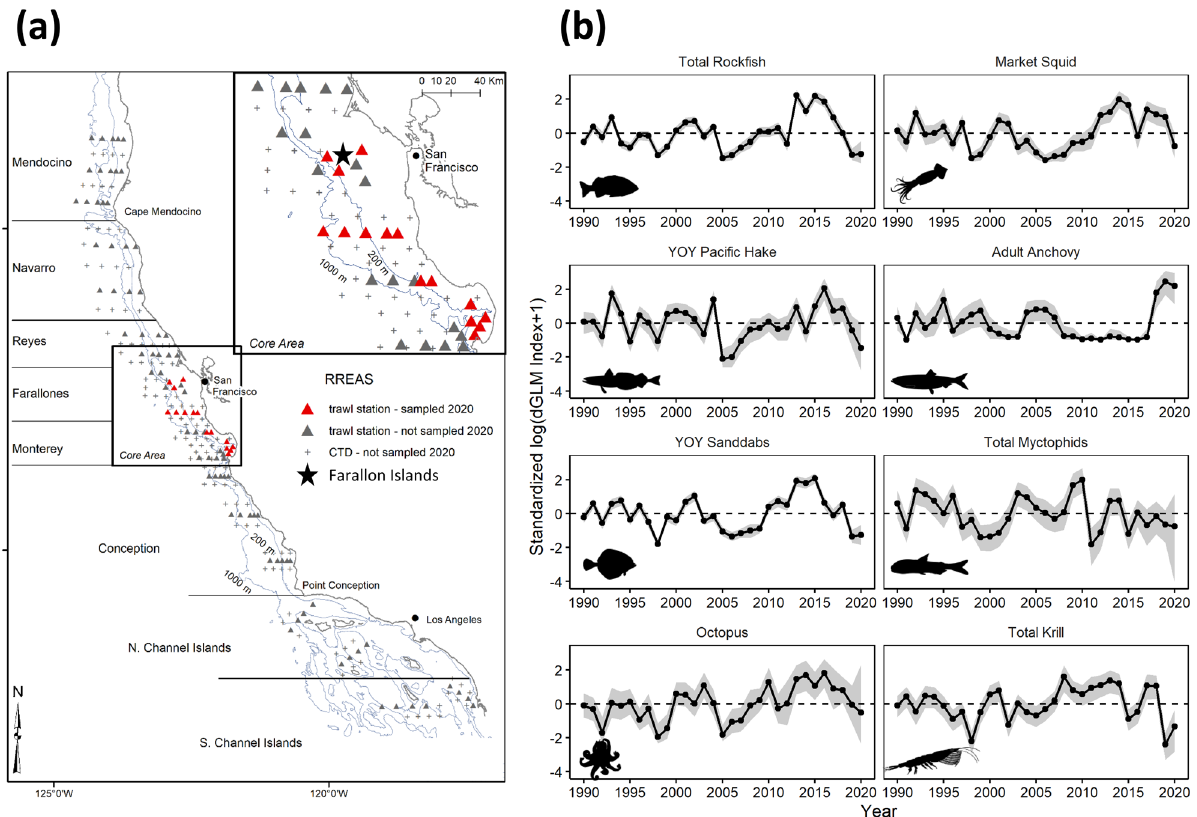
Fig. 1 Fisheries and ecosystem-assessment survey. a US West Coast and study area of the Rock fi sh Recruitment and Ecosystem Assessment Survey. Distribution of mid-water trawl and oceanographic sampling stations; inset core area showing stations sampled in 2020 (red) and location of seabird monitoring studies on southeast Farallon Island. b Standardized model-based estimates of forage taxa that are used for assessment of annual ecosystem state and future recruitment patterns; YOY is “ young-of-the-year. ” Error bands (shaded area) are 95% credible intervals. Map made in ArcGIS. Taxa silhouettes are derived from